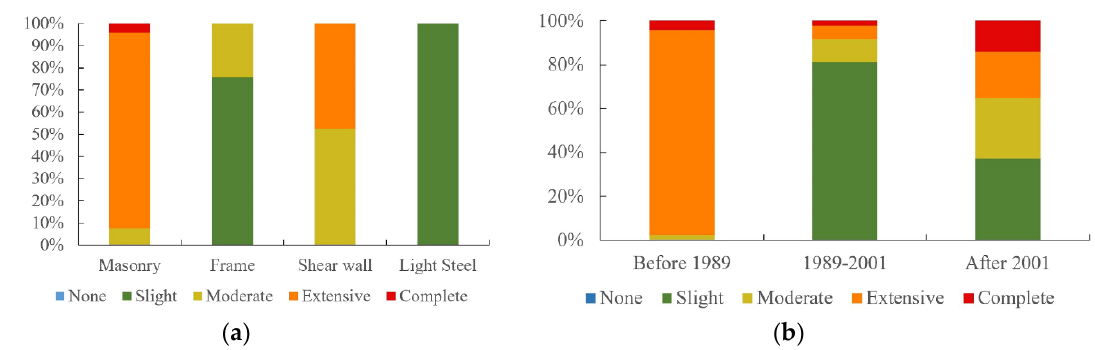
Figure 26. Seismic damage statistics by (a) structure type and (b) construction year.